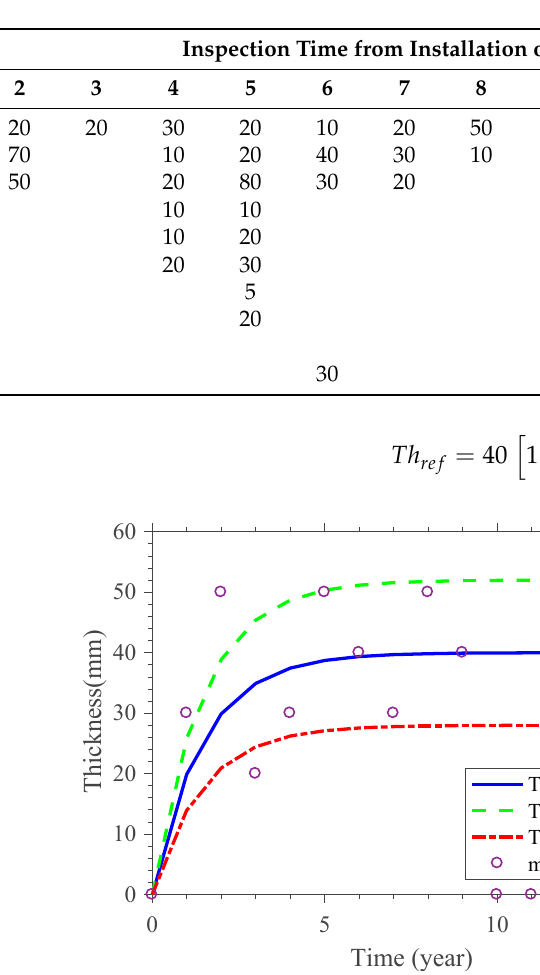
Table 1. Thickness measurements in the North Sea from [46].